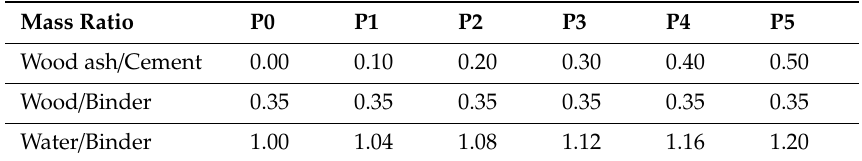
Table 4. Consistency test results.